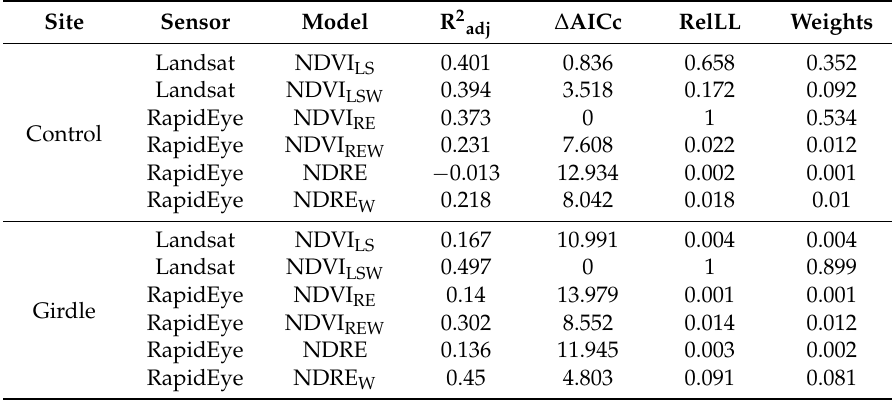
Figure 2. One to one plots of tower derived (measured) and predicted (modeled) gross primary productivity for the control (C, black) and girdled (G, grey) sites for all years of the study. See Table 1 for a description of model names. Table 3. Model performance statistics for all years of data. See Table 1 for a description of model names. R 2 adj is the adjusted R 2 , ∆ AICc is the difference in model AICc relative to the lowest scoring model, RelLL is the relative log likelihood, or how likely it is that each model is actually the best, and Weights is a list of the AICc weights for each